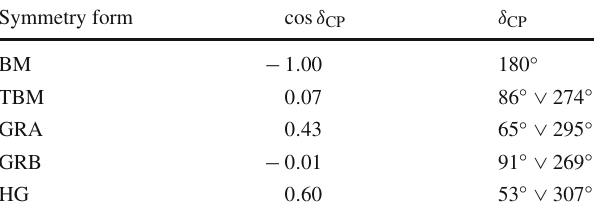
Table 6 The values of cos δ CP and δ CP for different symmetry forms obtained from the sum rule in Eq. (1.1) fixing sin 2 θ 12 = 0 . 3343 (its upper 2 σ bound) and two other mixing angles to their NO best fit values Symmetry form